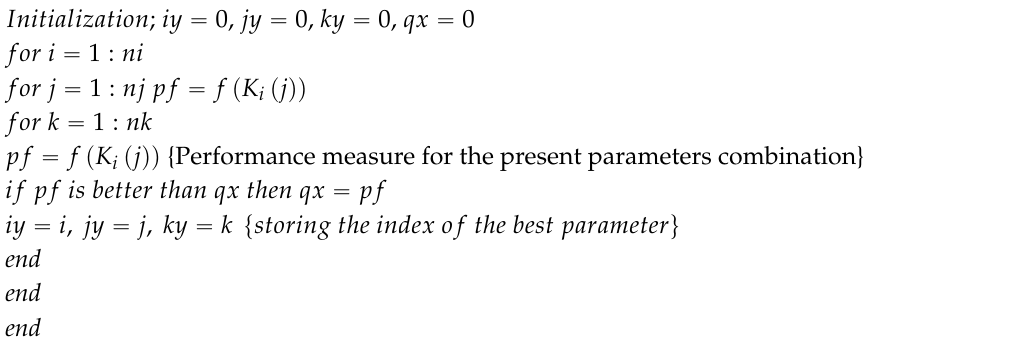
Algorithm 1. Optimal parameter search